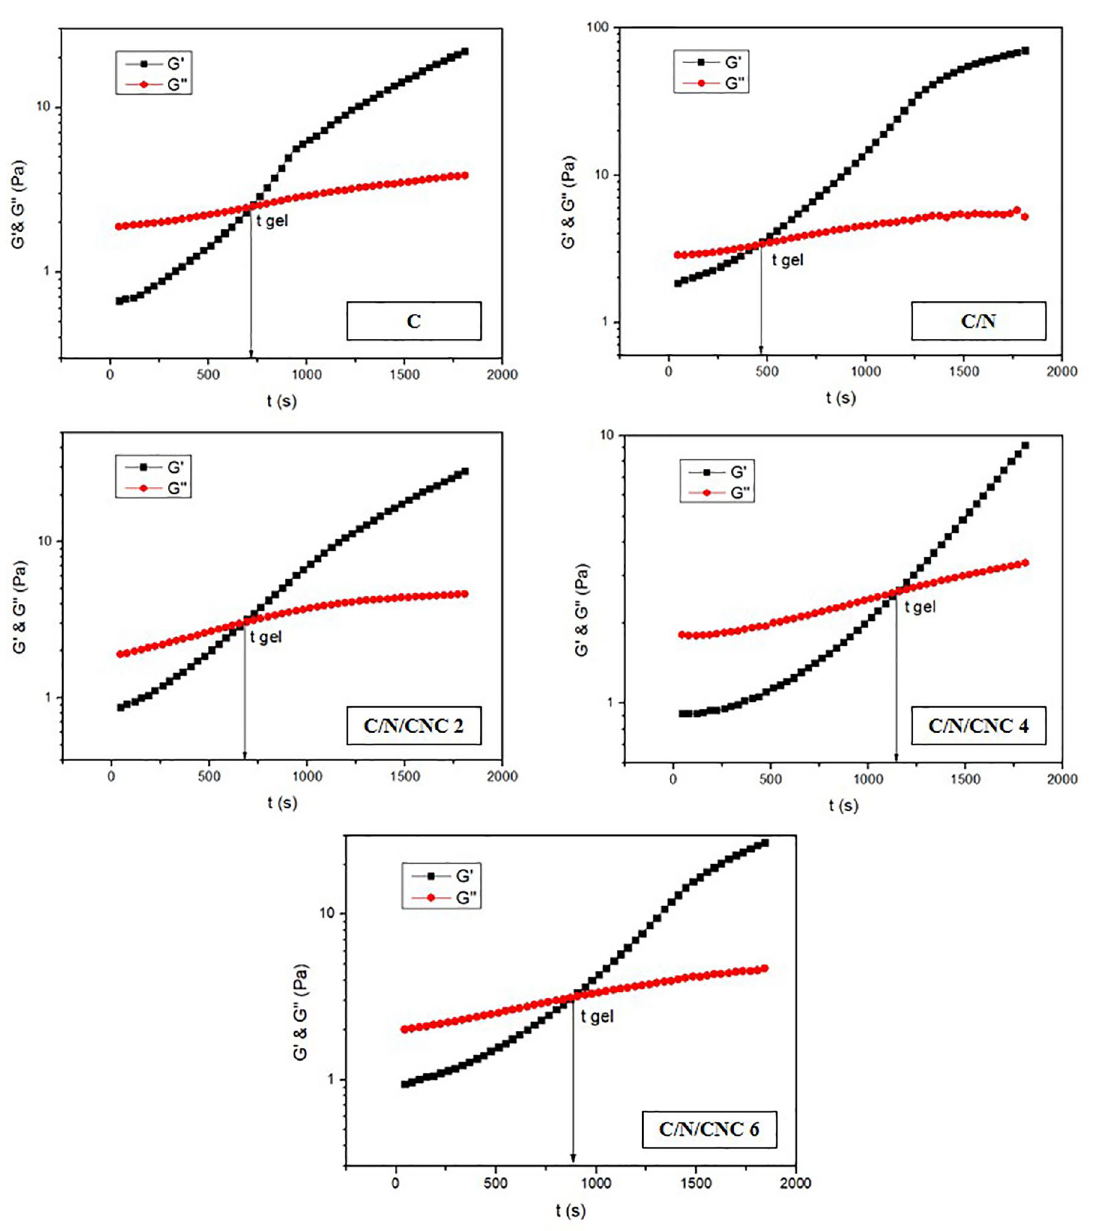
Figure 2. Time dependence of G' and G" for the C, C/N, C/N/CNC2, C/N/CNC4 and C/N/CNC6 hydrogels. Table 2. Gel time (t gel) and critical shear modulus (Gc) values of the hydrogels.